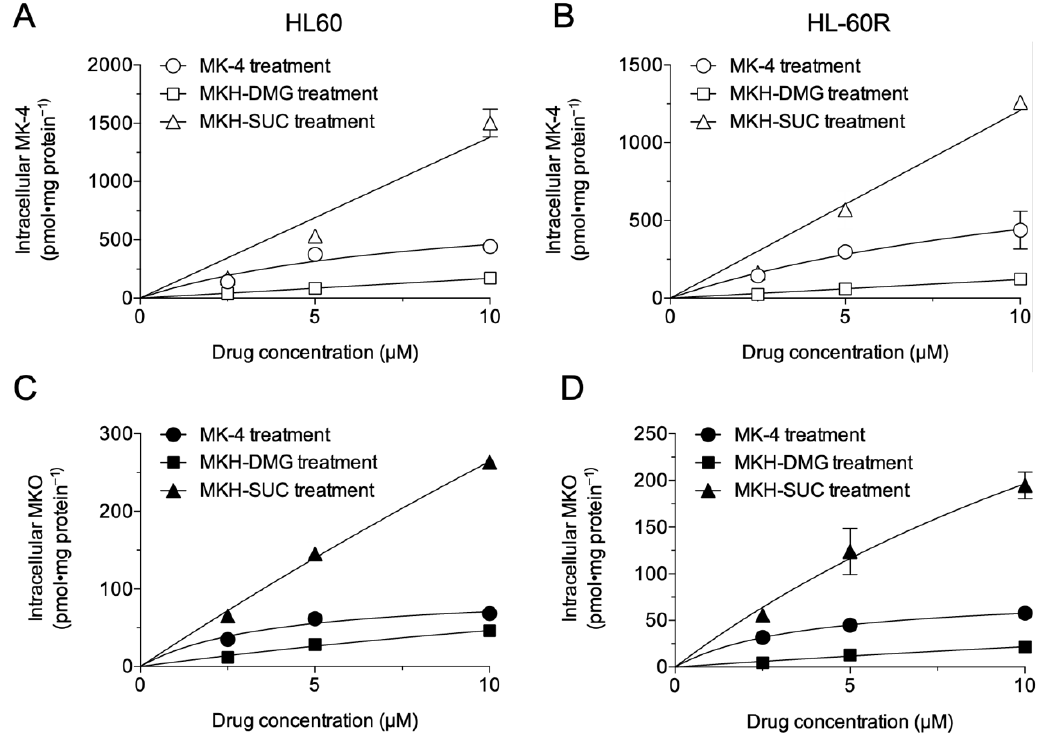
Figure 3. Intracellular level of MK-4 and MKO in HL60 and HL-60R cells treated with MK-4 or MKH derivatives. Intracellular MK-4 in HL60 ( A ) and HL-60R ( B ) cells treated with 2.5–10 µ M MK-4, MKH-DMG, or MKH-SUC for 24 h, and intracellular MKO in HL60 ( C ) and HL-60R ( D ) cells treated with 2.5–10 µ M MK-4, MKH-DMG, or MKH-SUC for 24 h. Plotted values are mean ± SD (n = 3).